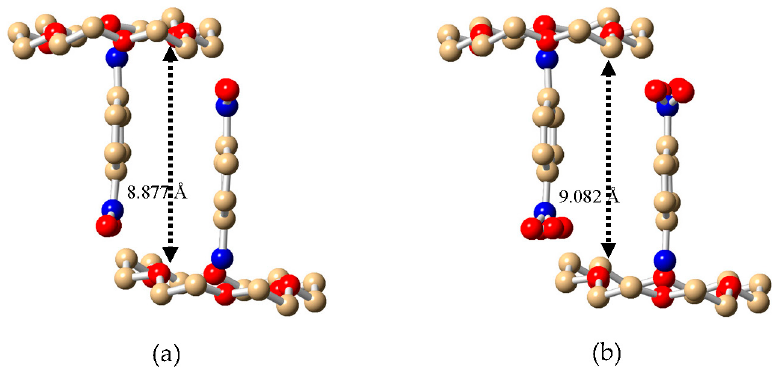
Figure 4. Arrangement of the supramolecular cations in 2 at 100 K ( a ) and 296 K ( b ) viewed along the a- axis; the dashed lines show the distance of the adjacent two crown ether rings.